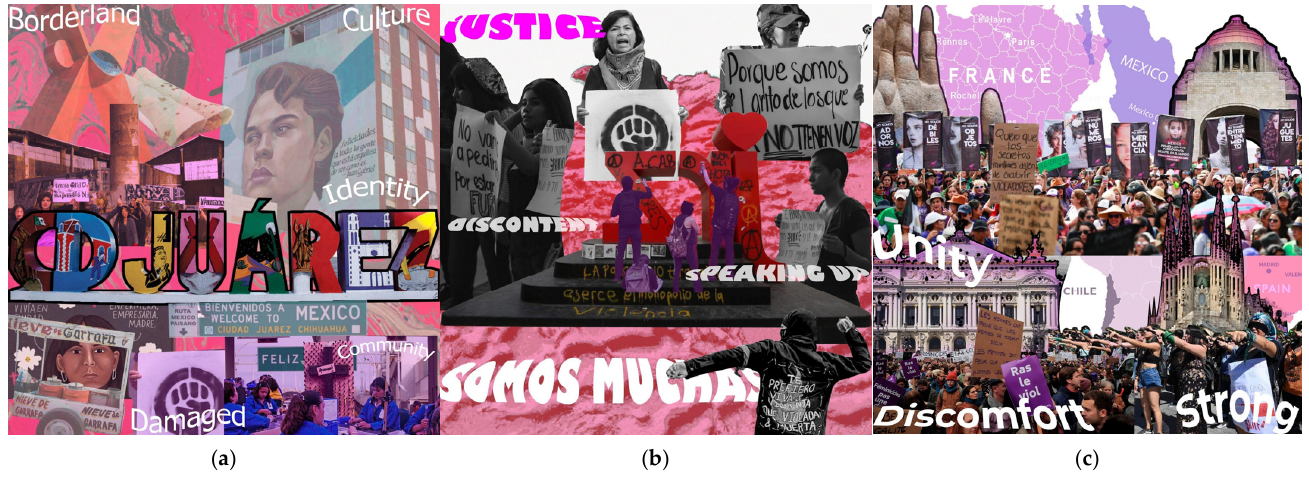
Figure 2. Radical femininity, Ciudad Juarez, Chih, Mexico (from left to right): ( a ) Juarez City poster, ( b ) Juarez feminist poster, ( c ) Worldwide poster, created by Natalia Dominguez, 2022. The feminist movement has become an integral part of Ciudad Juarez’s identity, owing to the extreme sexist mentality prevalent in the region. Feminists are fighting for women’s rights and equality for all communities, including immigrants, LGBTIQ+, and victims of abuse. The city is home to numerous murals, messages, and monuments